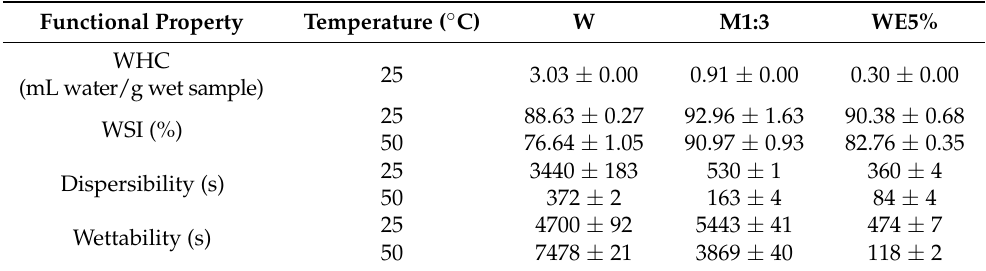
Table 6. ValuesforthefunctionalpropertiesofeggpowdersC,M1:3,andWE5%(means ± standarddeviation).